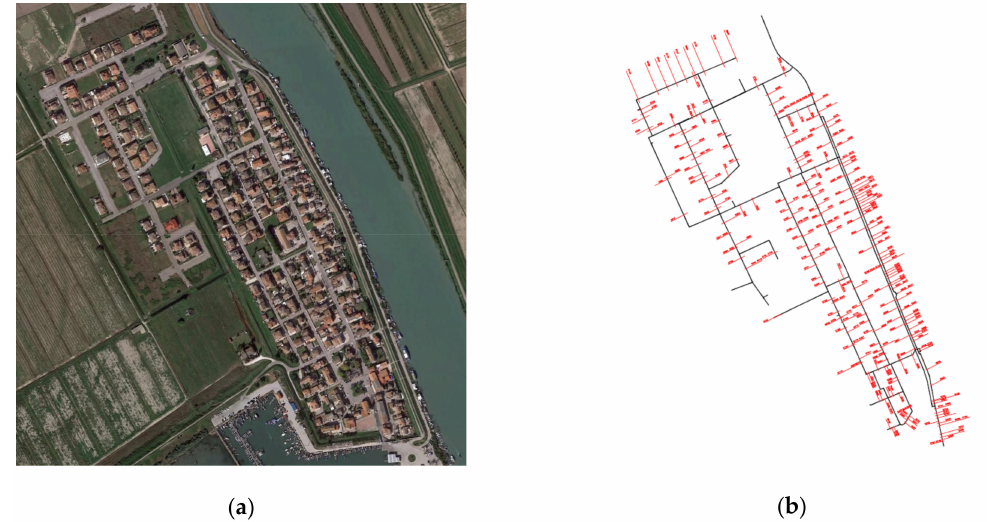
Figure 2. ( a ) A satellite view and ( b ) the network layout and user connections of the district metered area of Gorino Ferrarese (FE-Italy).